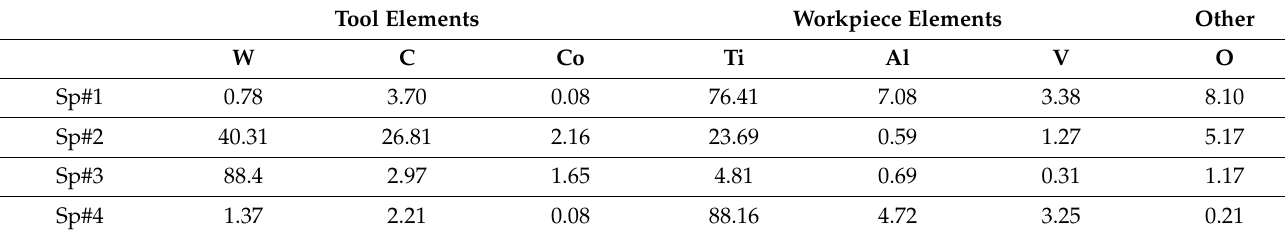
Table 8. EDS Spectral analysis of locations identified in Figure